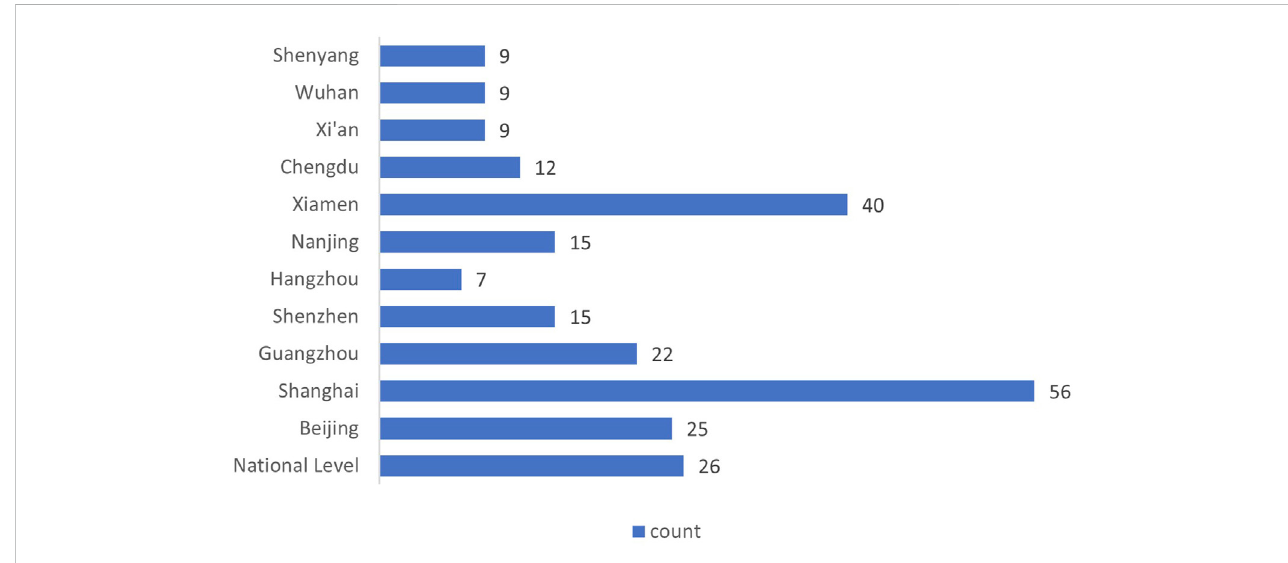
FIGURE 3 Source of MSWSM Policy in evaluation.